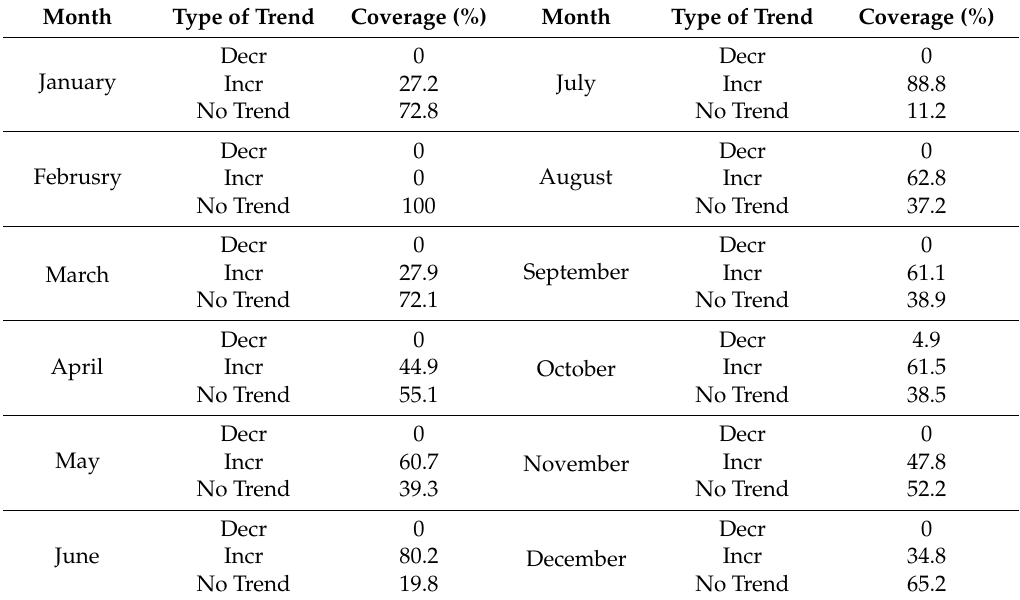
Table 3. Area (%) covered by AT in Iran and the Middle East (In this table: Decr = Decreasing, Incr =